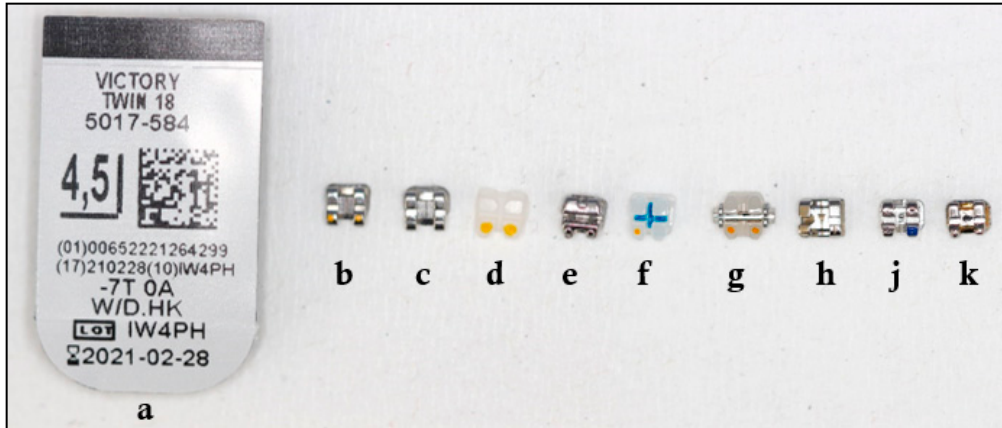
Figure 1. Brackets used in the study.